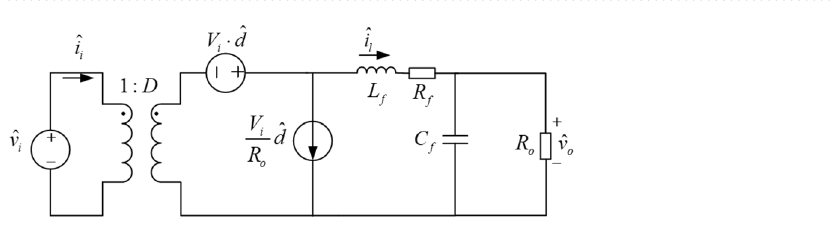
Figure 3. Simulation results of the opened-loop PSFD ZVS DC–DC converter.